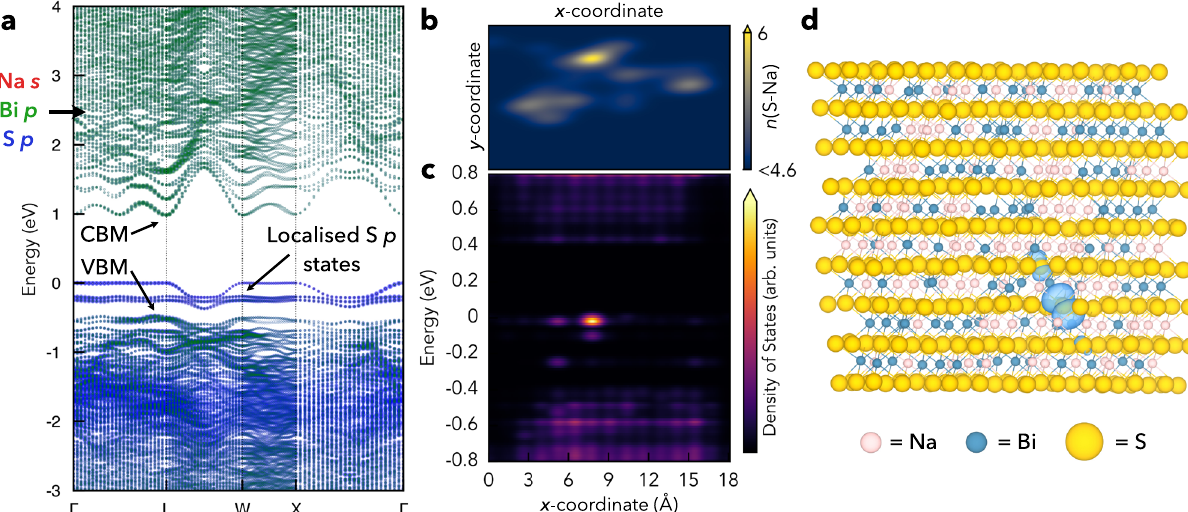
Fig. 2 | Electronic structure and localised states in NaBiS 2 . a Orbital-projected effective electronic band structure of disordered Fm (cid:1) 3 m NaBiS 2 calculated using hybrid DFT including spin-orbit interactions (HSE06+SOC) via the SQS supercell approach.ThesupercellcontainsoneS 2 − anioncoordinatedby6Na + cations,giving risetothethreelocalisedS p statesabovethedelocalisedvalencebandcontinuum. Sodium contributions (negligible) in red, bismuth in green and sulphur in blue. Corresponding Brillouin Zone path shown in Supplementary Fig. 6. b Heat map of the planar-averaged S – Na coordinatio n ( n (S – Na)) along the xy -plane of the NaBiS 2